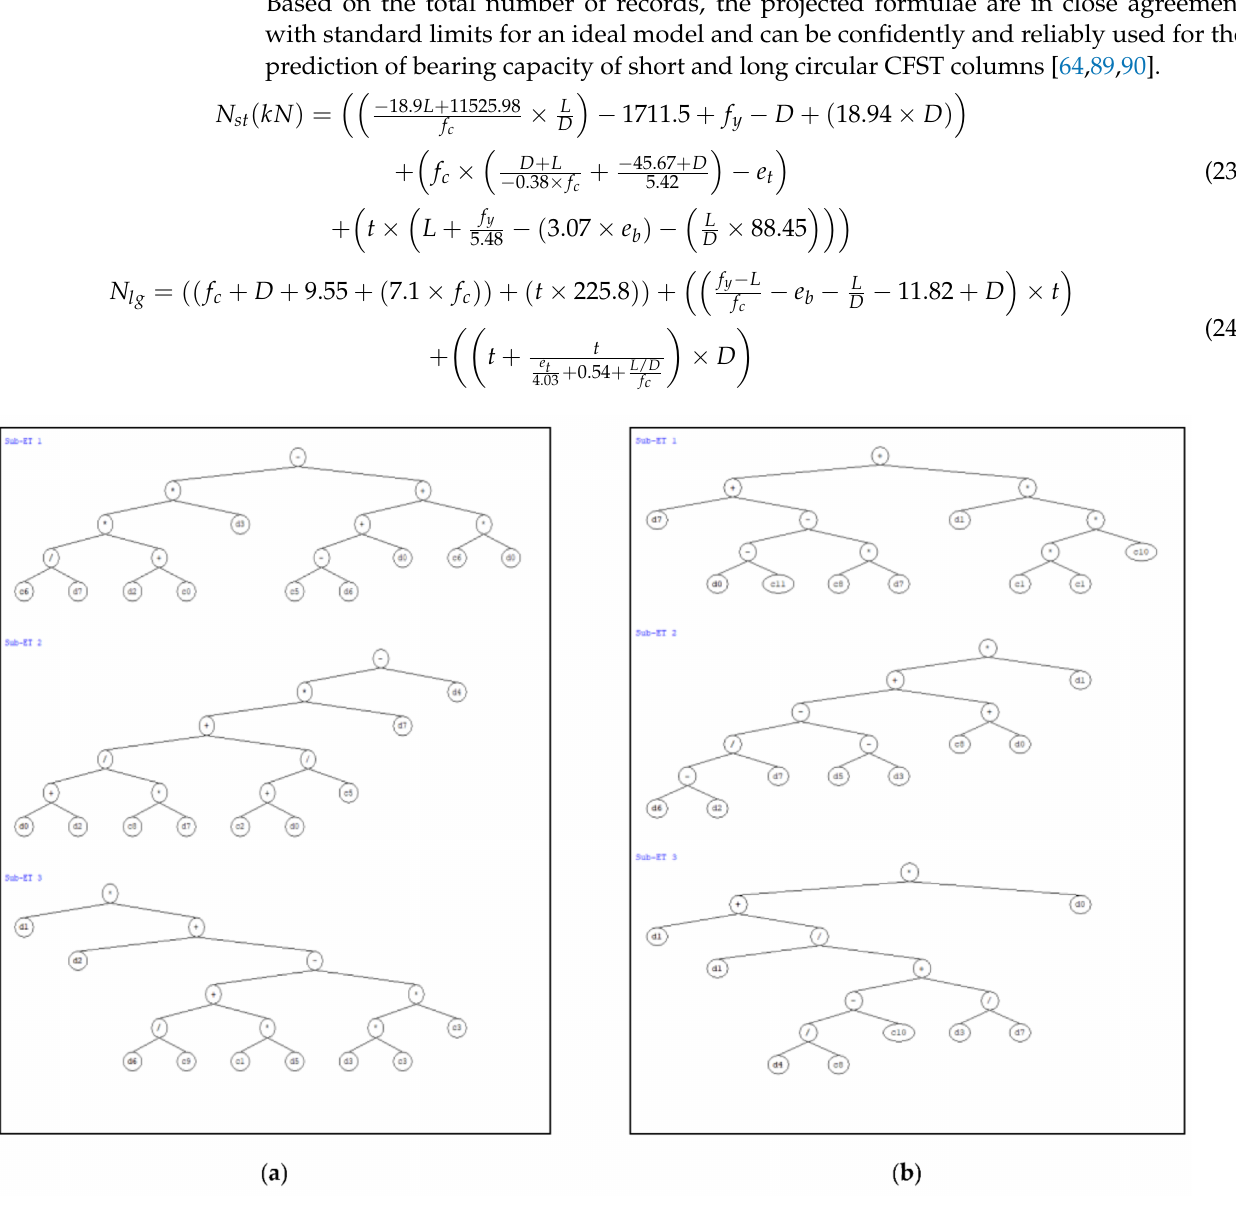
Figure 6. Representation of expression trees ( a ) Short circular CFST ( b ) Long circular